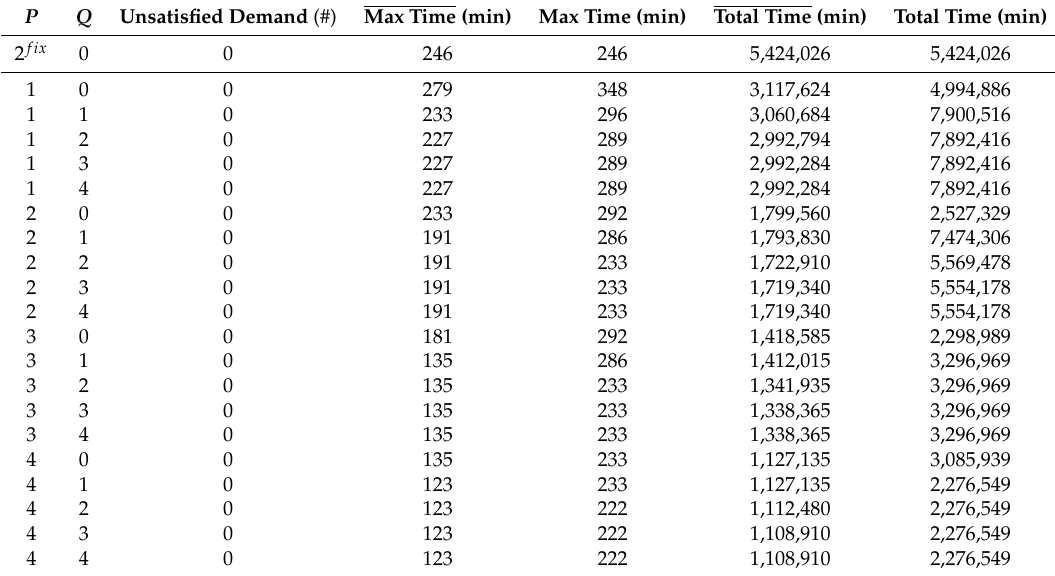
Table 2. Results for the experiment on the deterministic scenario with model-defined inventory